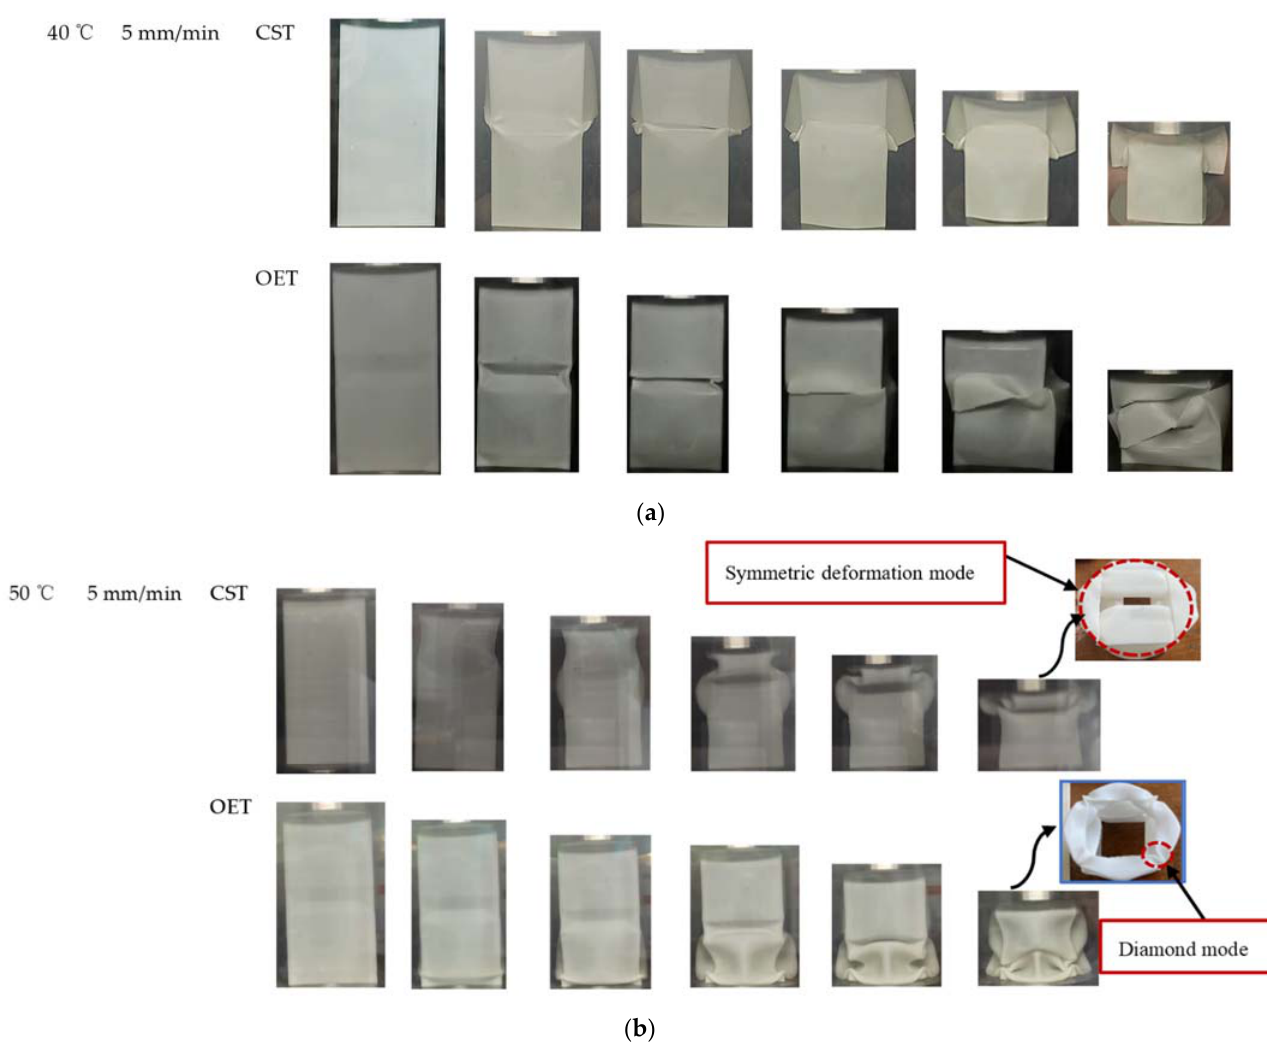
Figure 12. The compression rate at 5 mm/min: ( a ) Deformation mode of OET and CST at 40 °C; ( b ) deformation mode of OET and CST at 50 °C.